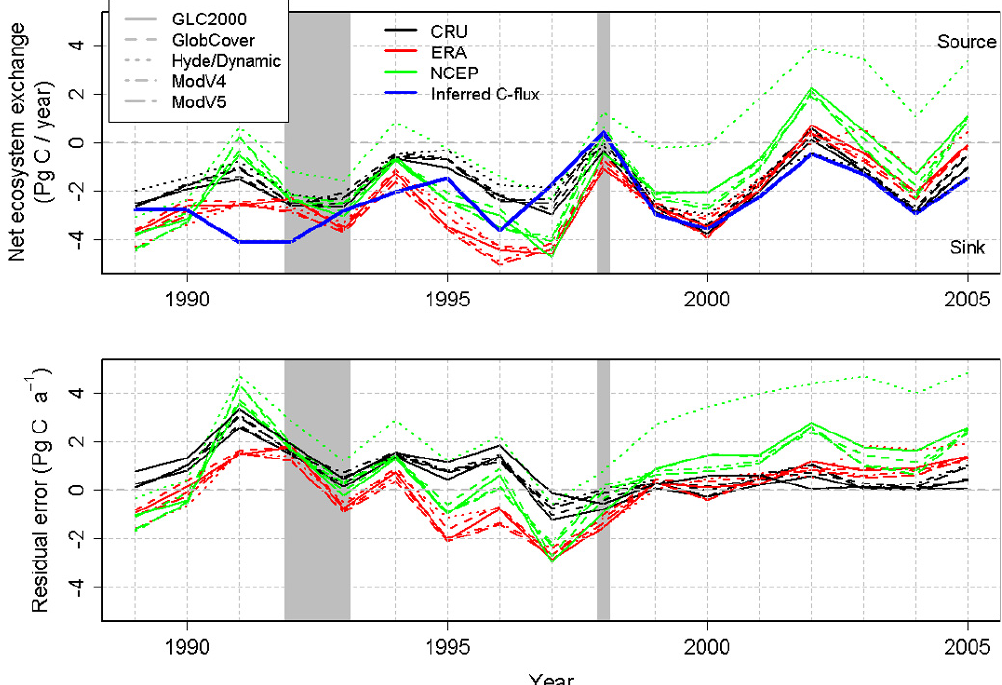
Fig. 3. (a) Temporal dynamics of net ecosystem exchange for the common overlapping time period of CRU, ERA-Interim, and NCEP-DOE (Table 1), and (b) the residual error from accounting method to assess global carbon sources and sinks (Sect. 3.1). The Mt. Pinatubo eruption and El Ni˜no Southern Oscillation event of 1997/98 are both